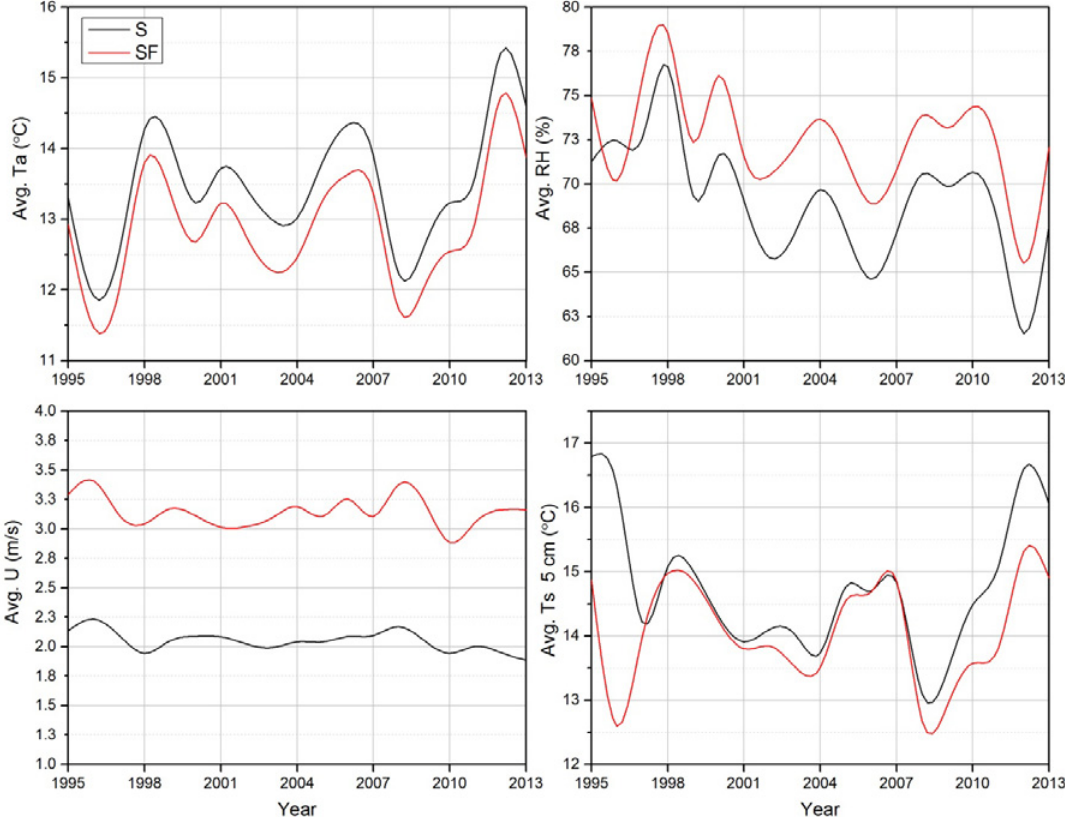
Figure 4. Average climatological variables (daily time series) at Sanborn (S, black line) and South Farm (SF, red line) monitoring sites from 18 January 1995 to 8 October 2013, Columbia, Missouri, USA. Ta = air temperature, Rh = relative humidity, U = wind speed, Ts = soil